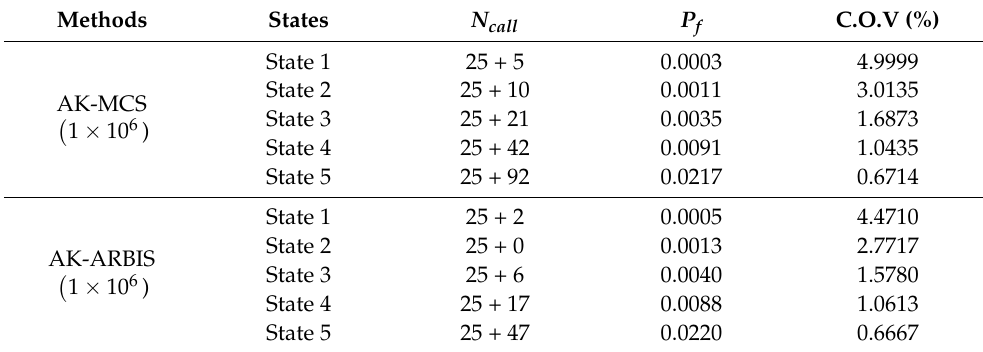
Table 8. Calculation results of adjusting